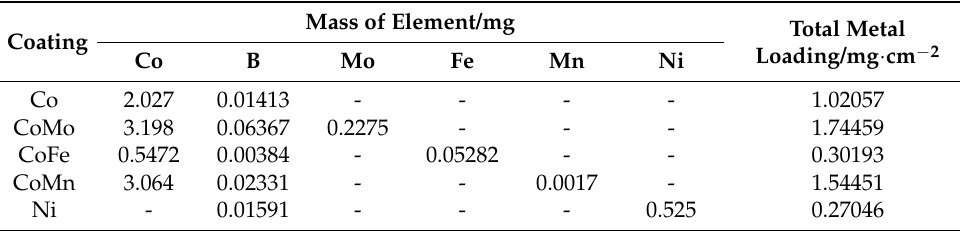
Table 2. Mass of the elements and total metal loading in the coatings as determined by inductively coupled plasma optical emission spectrometry (ICP–OES) analysis. Mass of Coating